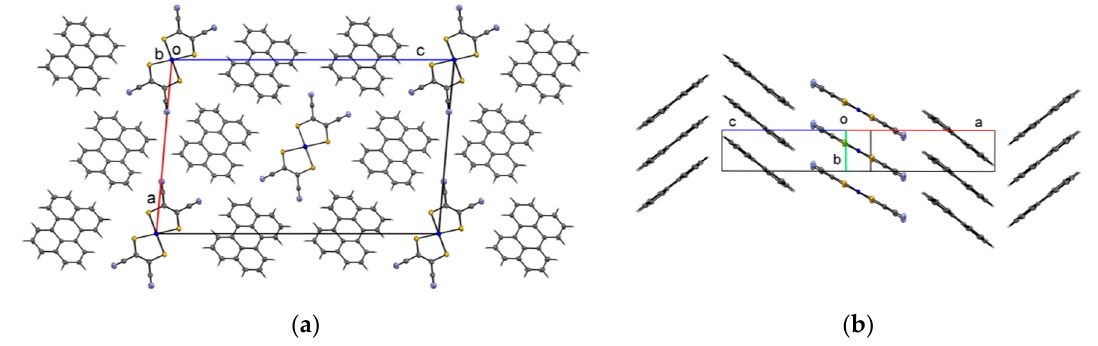
Figure 2. Crystal structure of α -(Per) 2 [Pt(mnt) 2 ]: ( a ) view along the b -axis, where segregated Per and [Pt(mnt) 2 ] stacks can be seen. Each [Pt(mnt) 2 ] stack is surrounded by six Per stacks, and each donor stack has three Per and three [Pt(mnt) 2 ] stacks as first neighbors; ( b ) Partial view perpendicular to the